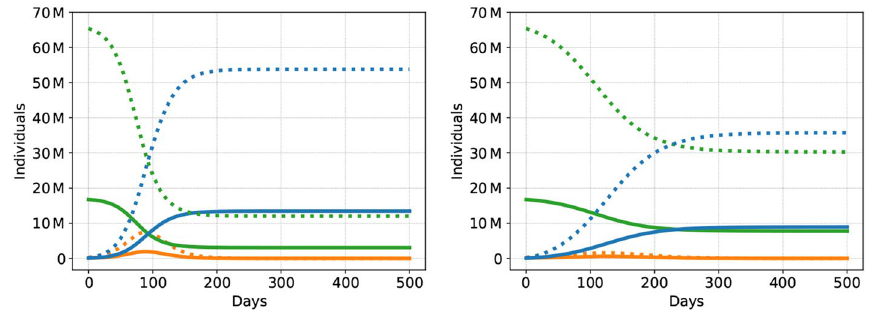
Figure 5. Dynamics of the COVID-19 epidemic for scenario B2-Trace with low (20 % ) compliance by both groups (ll, left) and with mixed (20 % by group H and 80 % by group L) compliance (hl, right). Susceptible individuals in green, recovered in blue, and aggregated asymptomatic, symptomatic, and severely infectious cases in orange. The group with low vulnerability has dotted curves, the group with high vulnerability is plotted solidly.